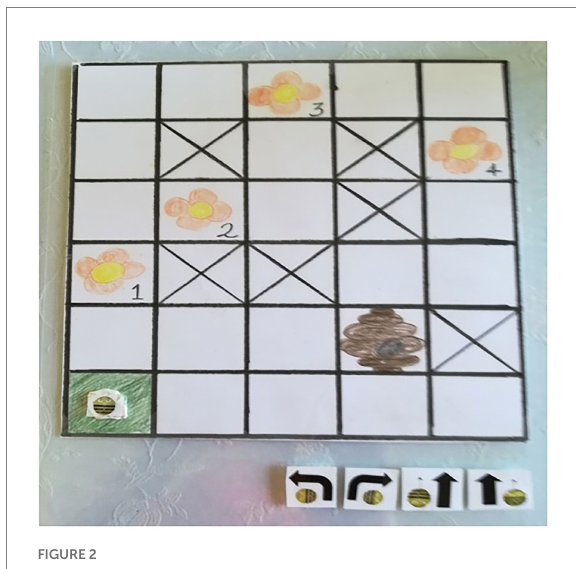
FIGURE 2 Model-based scaffolding